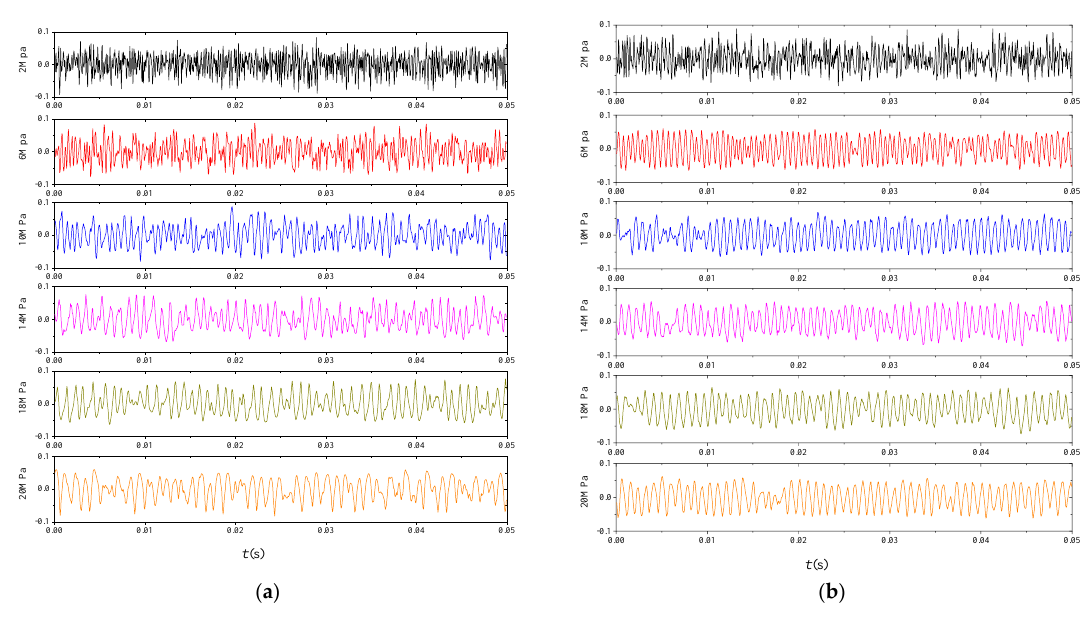
Figure 10. Time-domain distribution for mode_1 of the cavitating jet images. ( a ) Cavitating jet by nozzle without whistle. ( b ) Cavitating jet by nozzle with divergent whistle.